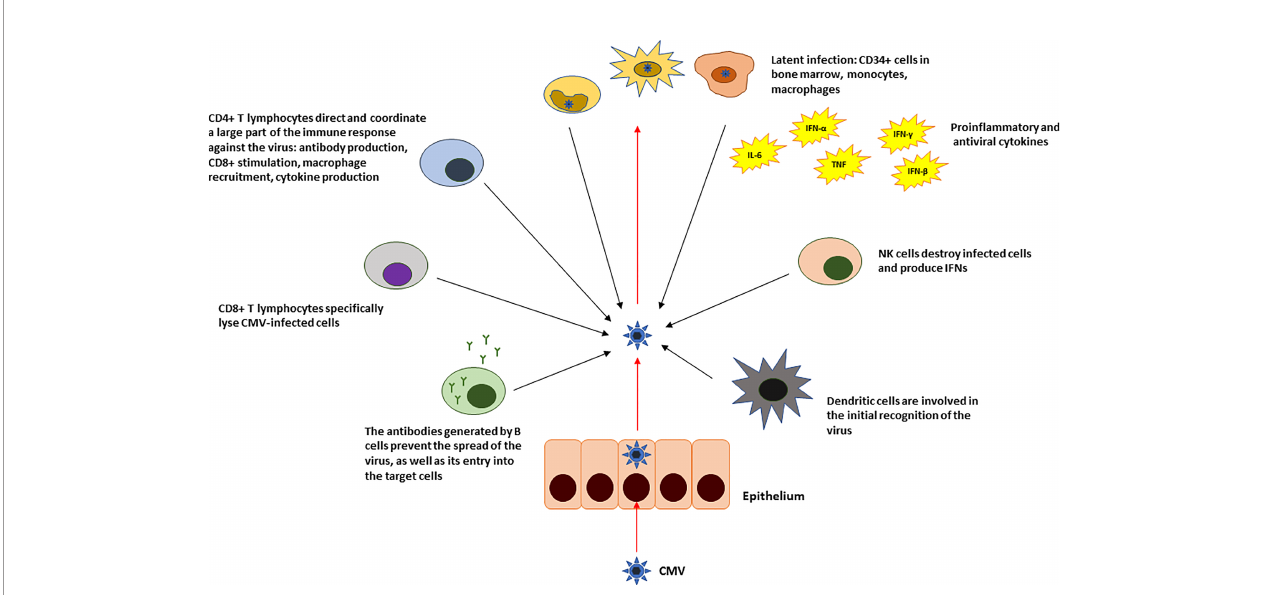
FIGURE 1 | Summary of the innate and adaptive immune response against CMV in immunocompetent